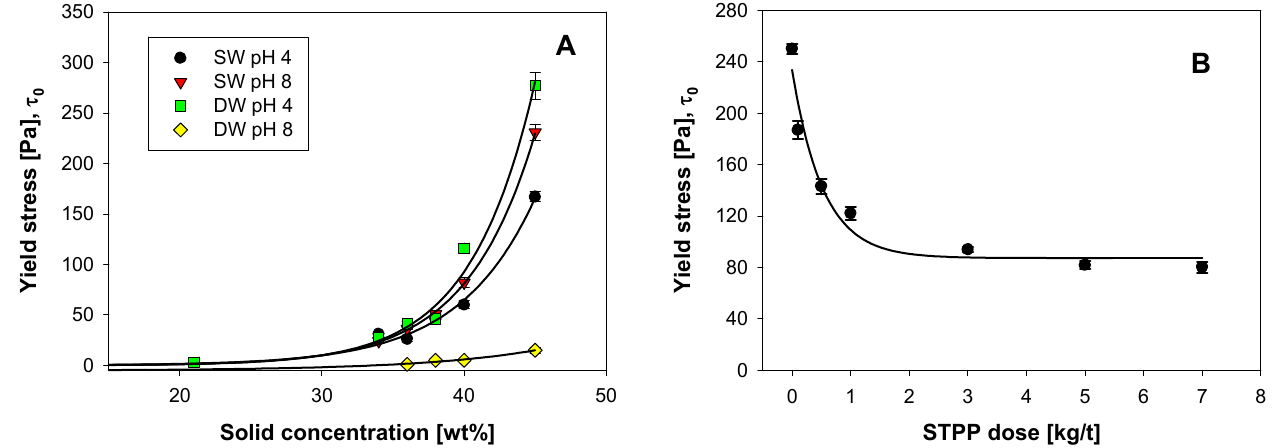
Figure 3. ( A ) Yield stress of kaolin slurries prepared in seawater (SW) and distilled water (DW); ( B ) effect of sodium tripolyphosphate (STPP) on yield stress of kaolin slurries in seawater at pH 8.